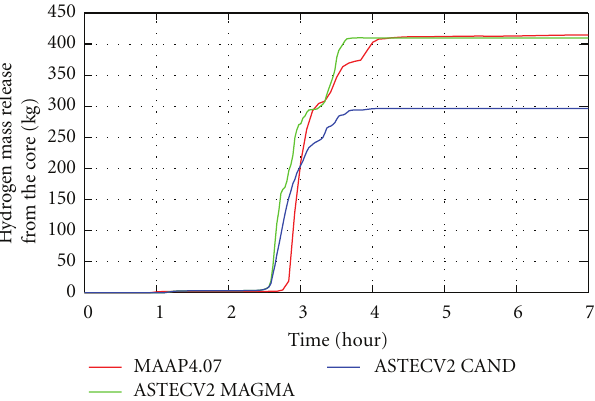
Figure 9: Comparison ASTEC-MAAP of produced in-vessel hydro- gen in a reactor